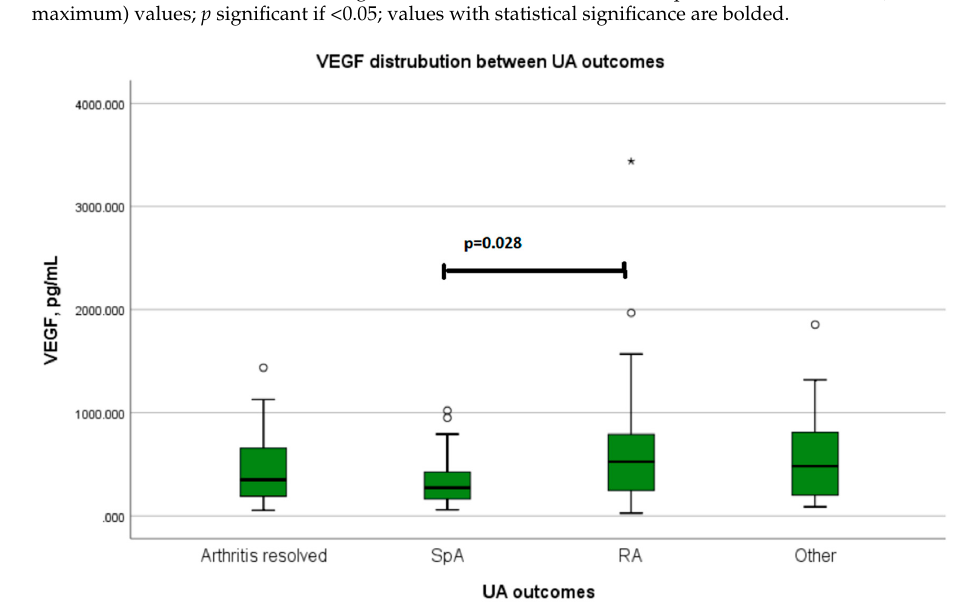
Figure 1. VEGF level distribution at the onset of undifferentiated arthritis between disease outcomes